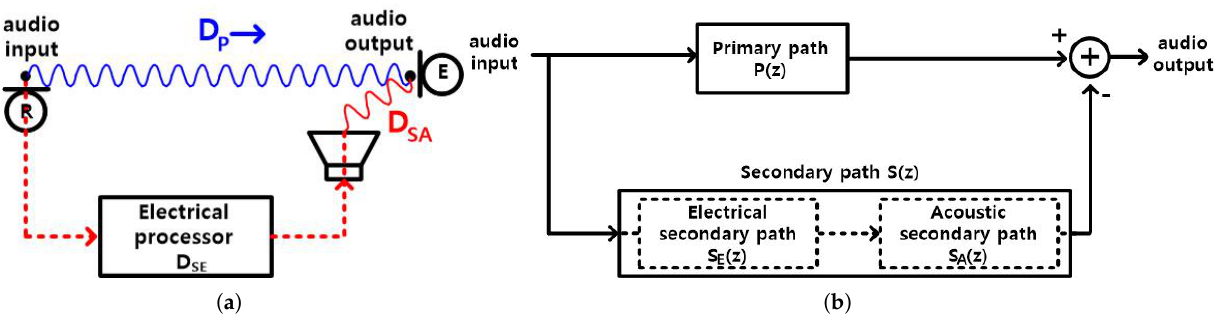
Figure 1. Feedforward ANC ( a ) time delay and ( b ) block diagram. Blue: Primary path, Red: Secondary path.